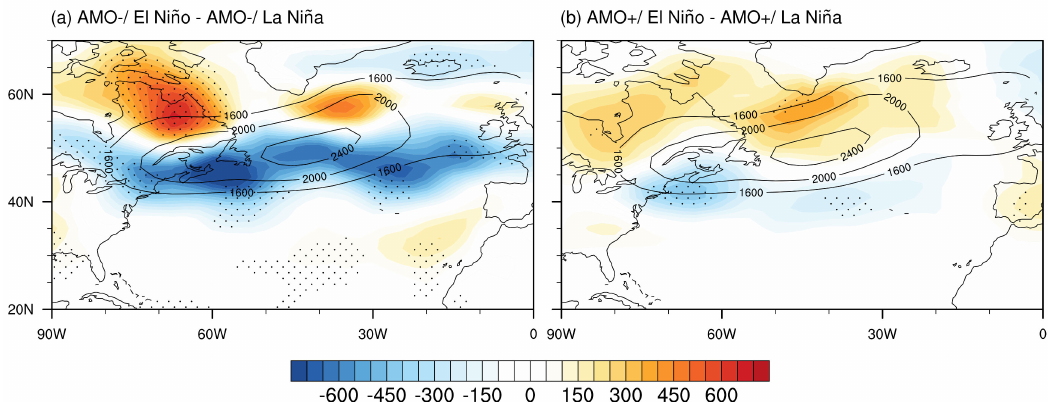
Figure 9. Simulated differences of the spring AST (shading; units: m 2 ) in CAM5.1 between: ( a ) AMO − /El Niño and AMO − /La Niña; and ( b ) AMO+/El Niño and AMO+/La Niña. The contours represent the spring climatological AST in CTRL. Stippling represents significance exceeding the 95% confidence level.